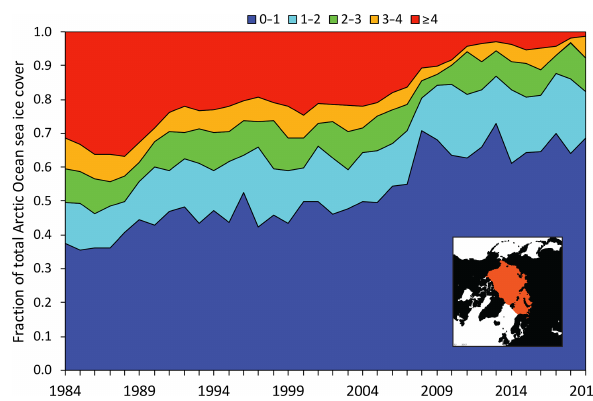
Figure 11. Time series of fraction of total sea ice coverage by sea ice age category for the week of 19–25 February 1984–2019. These time series are for the Arctic Ocean region, which is the region shaded in orange in the lower right inset image (Perovich et al., 2019), used to include only regions were MYI may exist at a non- negligible